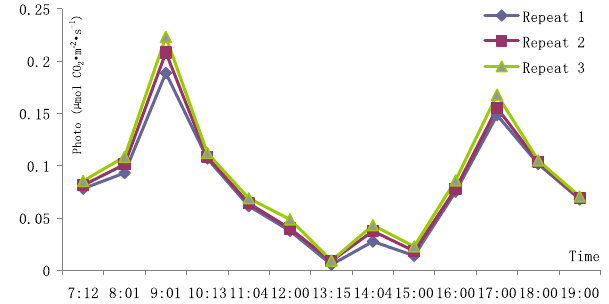
Figure 1. Diurnal variations in Epimedium brevicornu leaves